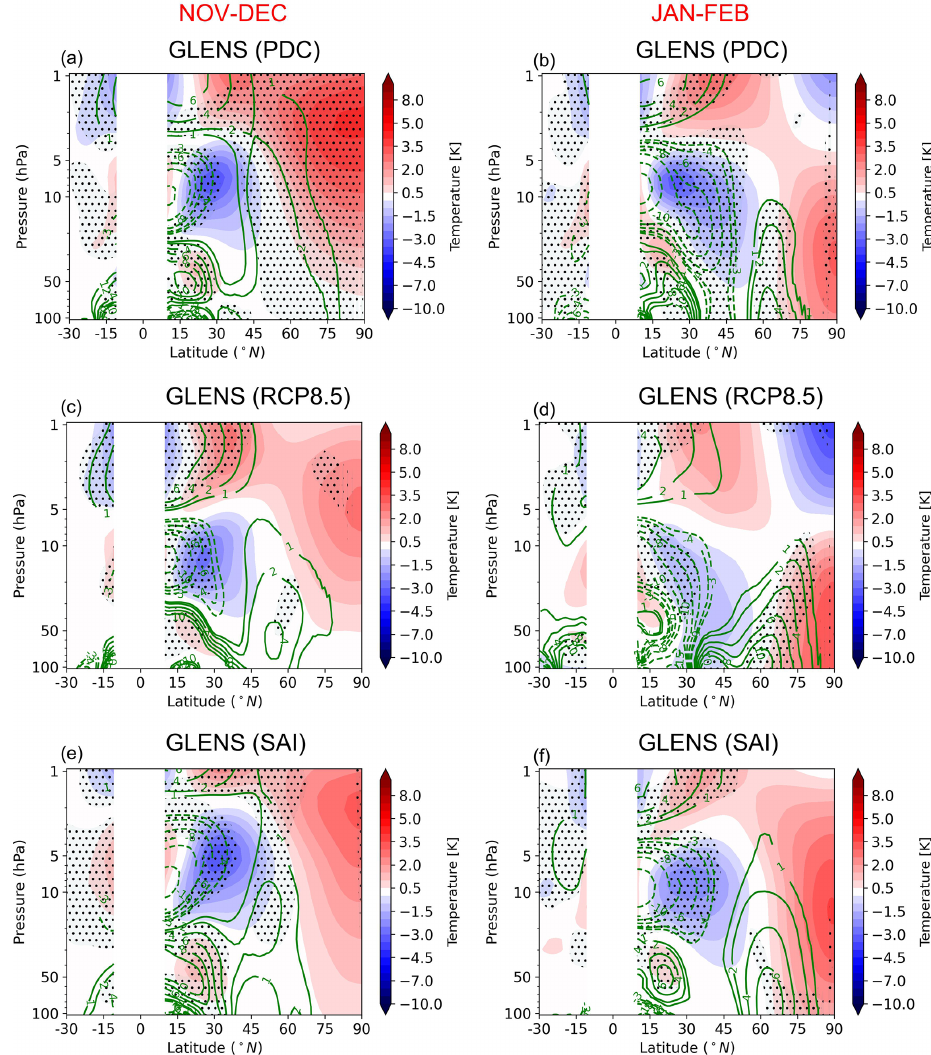
Figure 11. The same as Fig. 9 but for the contribution from the unresolved gravity waves.